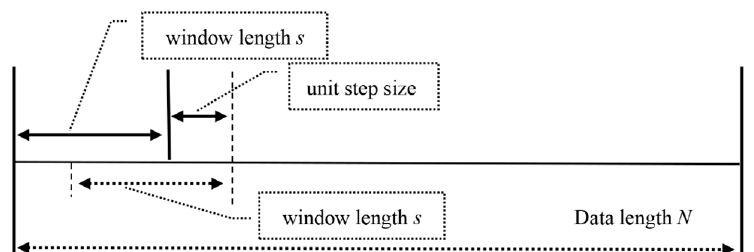
Figure 1. Details of sliding-window segmentation.